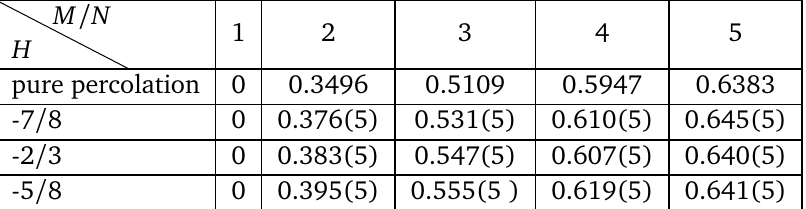
Table 5: Best fit parameter c (48). The first line gives the numerical value of prediction (25) for pure percolation.